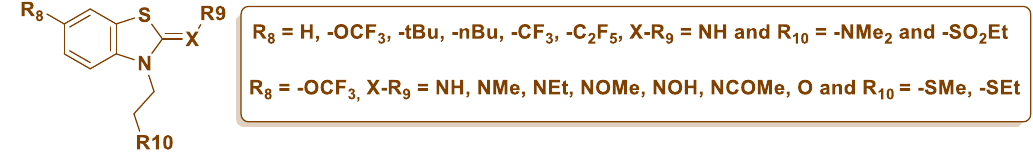
Figure 8. Simultaneous modifications in positions 3 and 6, and 2 and 3.